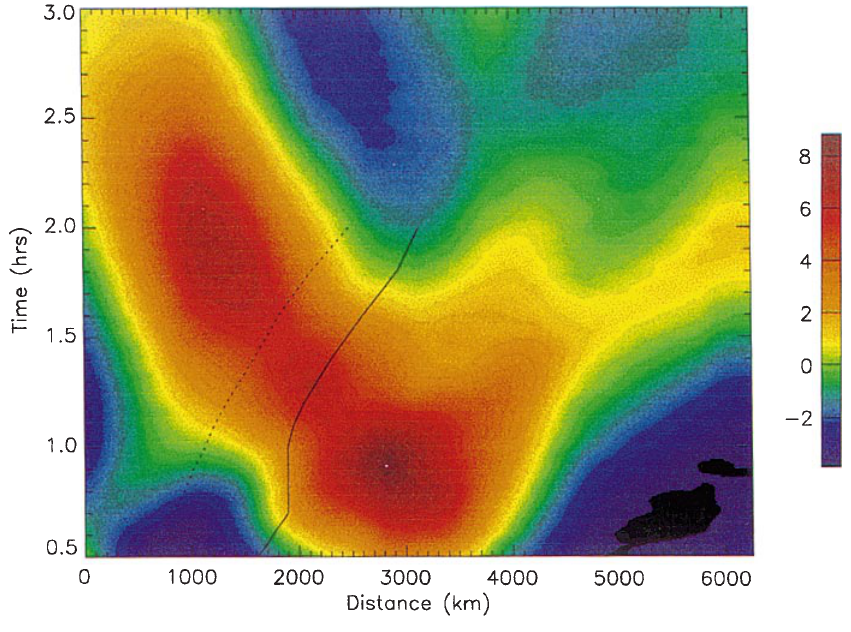
Fig. 9. Colour contour plot of the time history of the neutral density perturbation at 300 km along the approximate path of the plasma patch. The horizontal axis indicates the distance from the throat along the path indicated in Figure 8. The vertical axis indicates the time in hours after 1900 UT. The solid and dotted lines indicate the motion of the plasma patch and trailing trough respectively